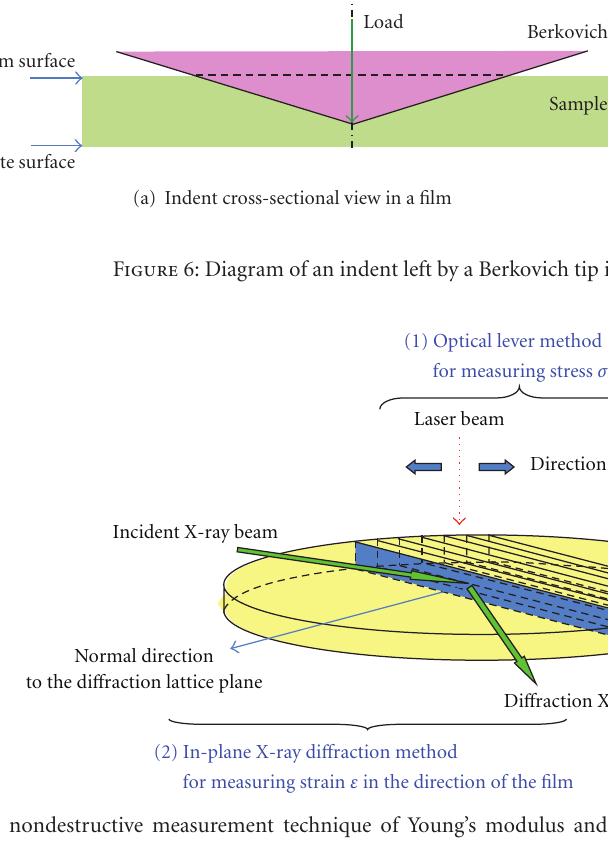
Figure 7: Diagram of a nondestructive measurement technique of Young’s modulus and coe ffi cient of linear thermal expansion of a polycrystalline film which uses the optical lever technique for measuring the residual stress in conjunction with the in-plane X-ray di ff raction technique for measuring